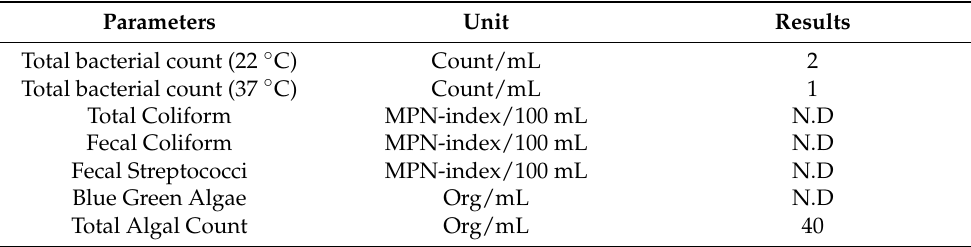
Table 7. Biological and microbiological examination of sea